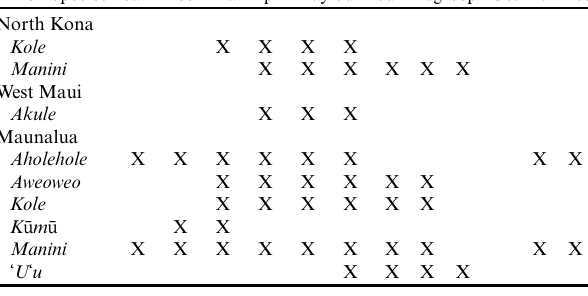
Table 2 . Spawning seasons for several harvested fish species from North Kona (Hawai ʻ i), West Maui (Maui), and Maunalua Bay (Oahu) from January 2013 to January 2015. Some spawning was found to occur outside peak spawning seasons and annual variability was also found to occur. These spawning seasons are guidelines for which to compare temporal changes in spawning cycles at each location. See Table 1 for species common and scientific names.